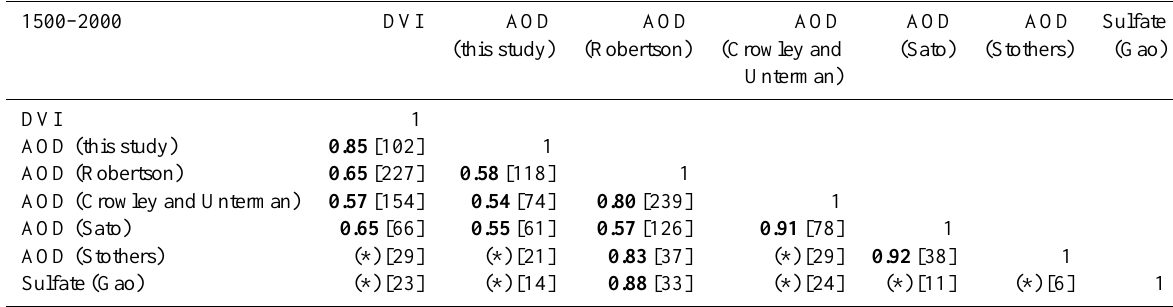
Table 1. Correlation coefficients between volcanic aerosol indices and AOD proxies shown in Fig.